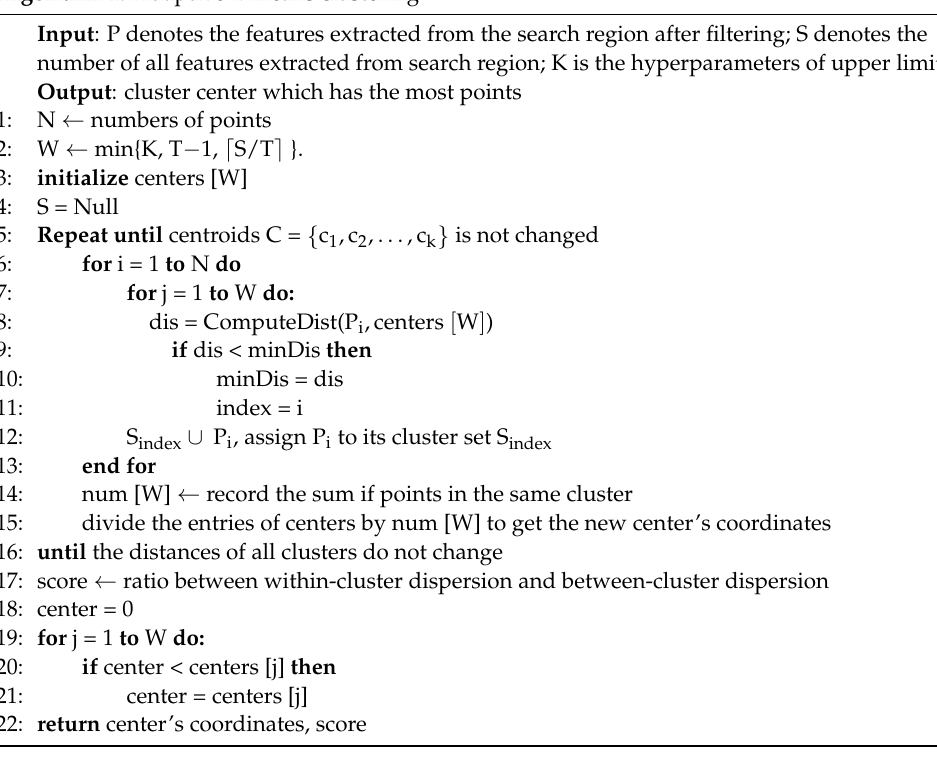
Algorithm 1: Adaptive k-means clustering.